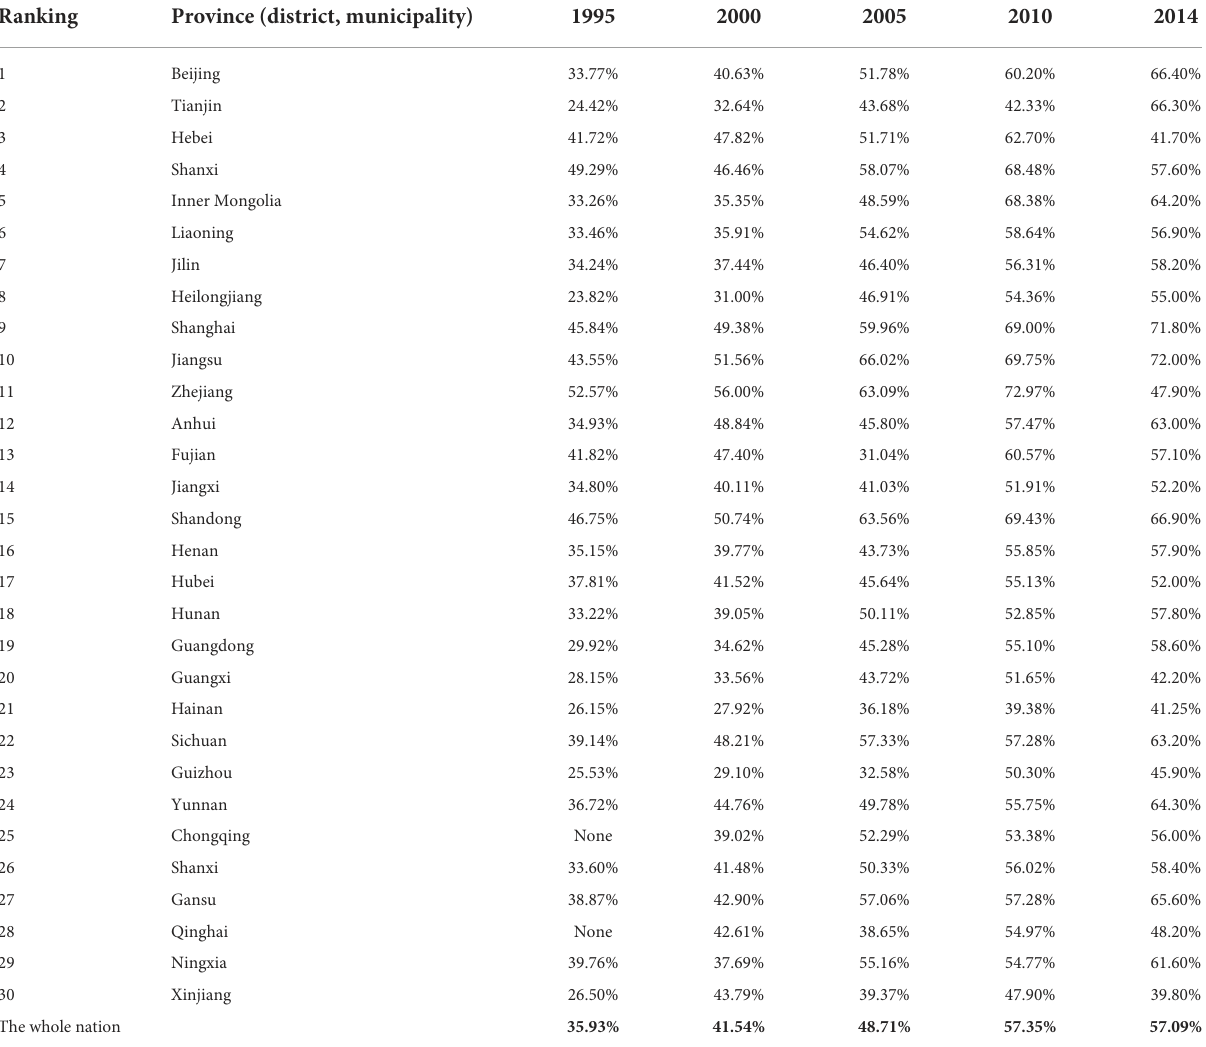
TABLE 2 The prevalence of myopia among children and adolescents in all provinces of China from 1995 to 2014.